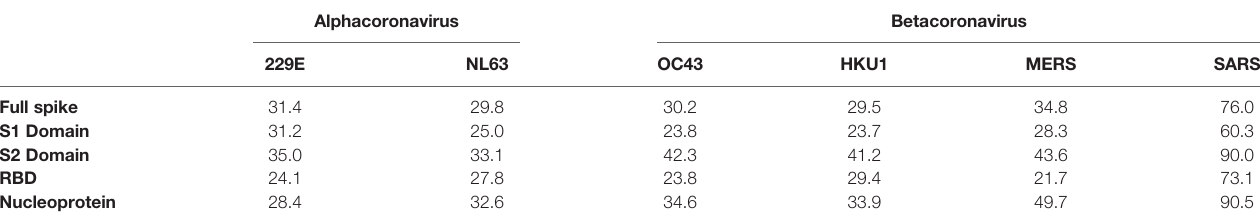
TABLE 1 | Percent identity of amino acid sequences between human CoVs and SARS-CoV-2.